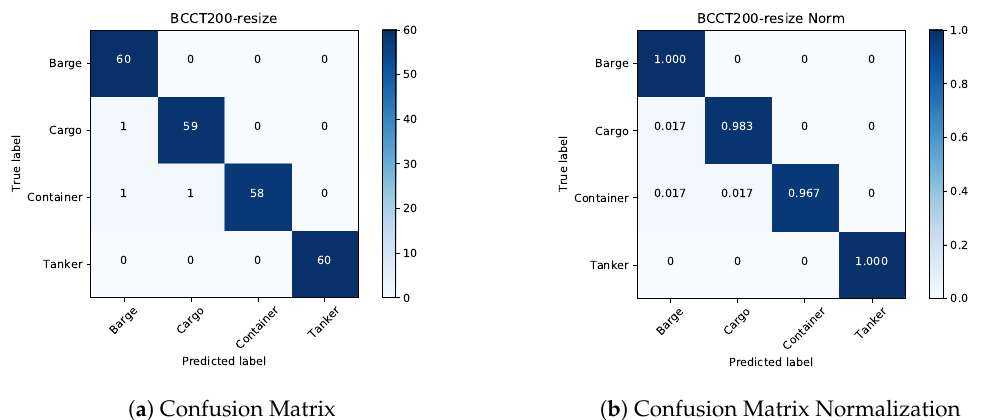
Figure 12. Classification confusion matrix of the proposed ME-CNN using the BCCT200-resize data.